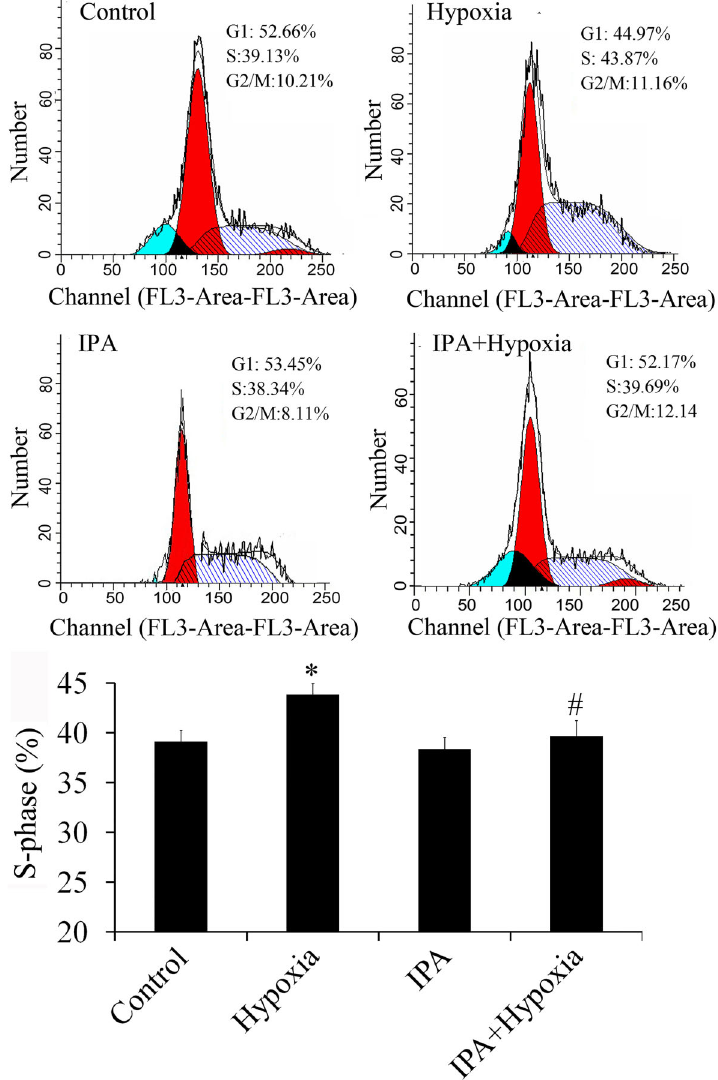
Figure 3. Effects of inactivated P. aeruginosa (IPA) on proliferation of primary arterial smooth muscle cells (PASMCs) (n=4) in rats. Hypoxia promoted the proliferation of PASMCs, and IPA inhibited the proliferation of PASMCs induced by hypoxia. *P o 0.05 vs control; # P o 0.05 vs hypoxia